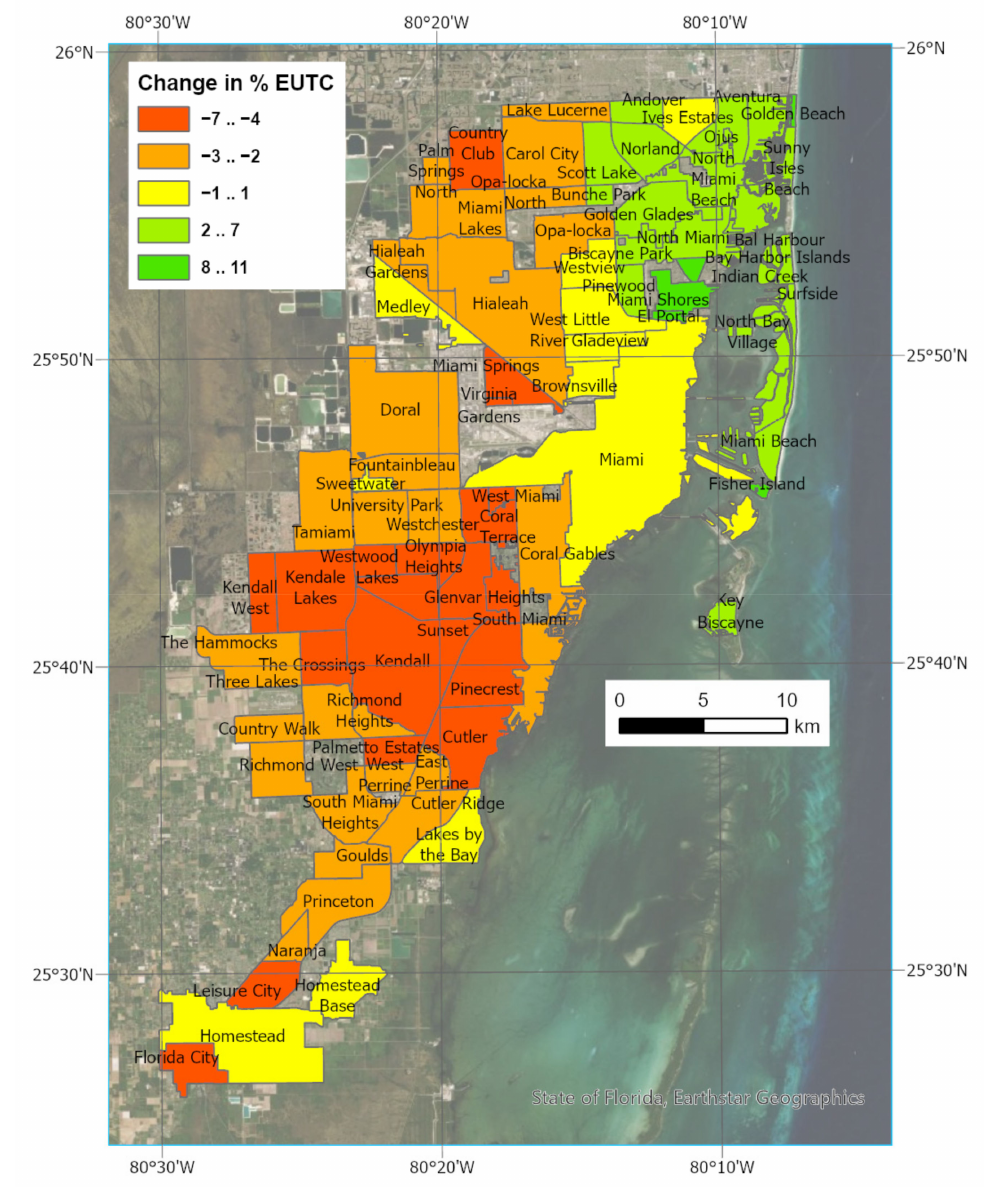
Figure 3. Change in % EUTC for census places within the UDB of Miami-Dade County (background map credits: State of Florida, Earthstar